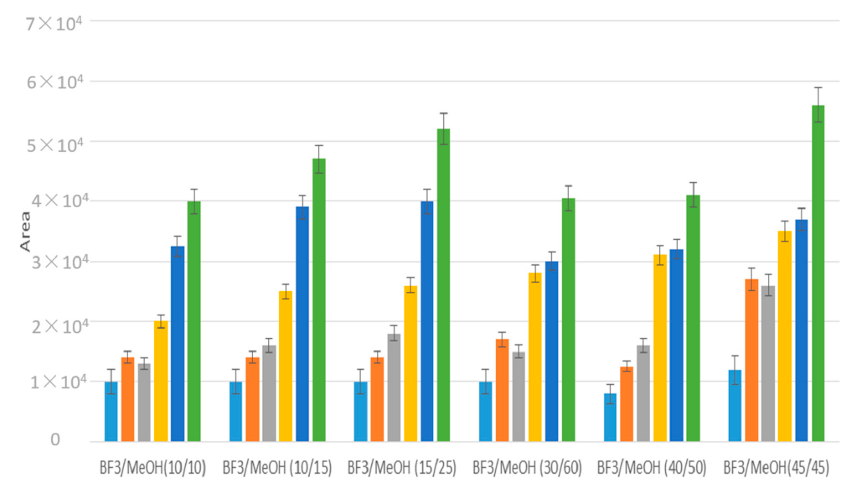
Figure 5. Optimization of BF 3 -MeOH and MeOH ratios (% / %) for the derivatization of a 2 mL water solution of low molecular weight fatty acids (C 4 blue, isoC 4 orange, C 5 grey, iso C 5 yellow, C 6 dark blue, C 7 green) with CH 2 Cl 2 liquid / liquid extraction. Analyses were performed in triplicates.